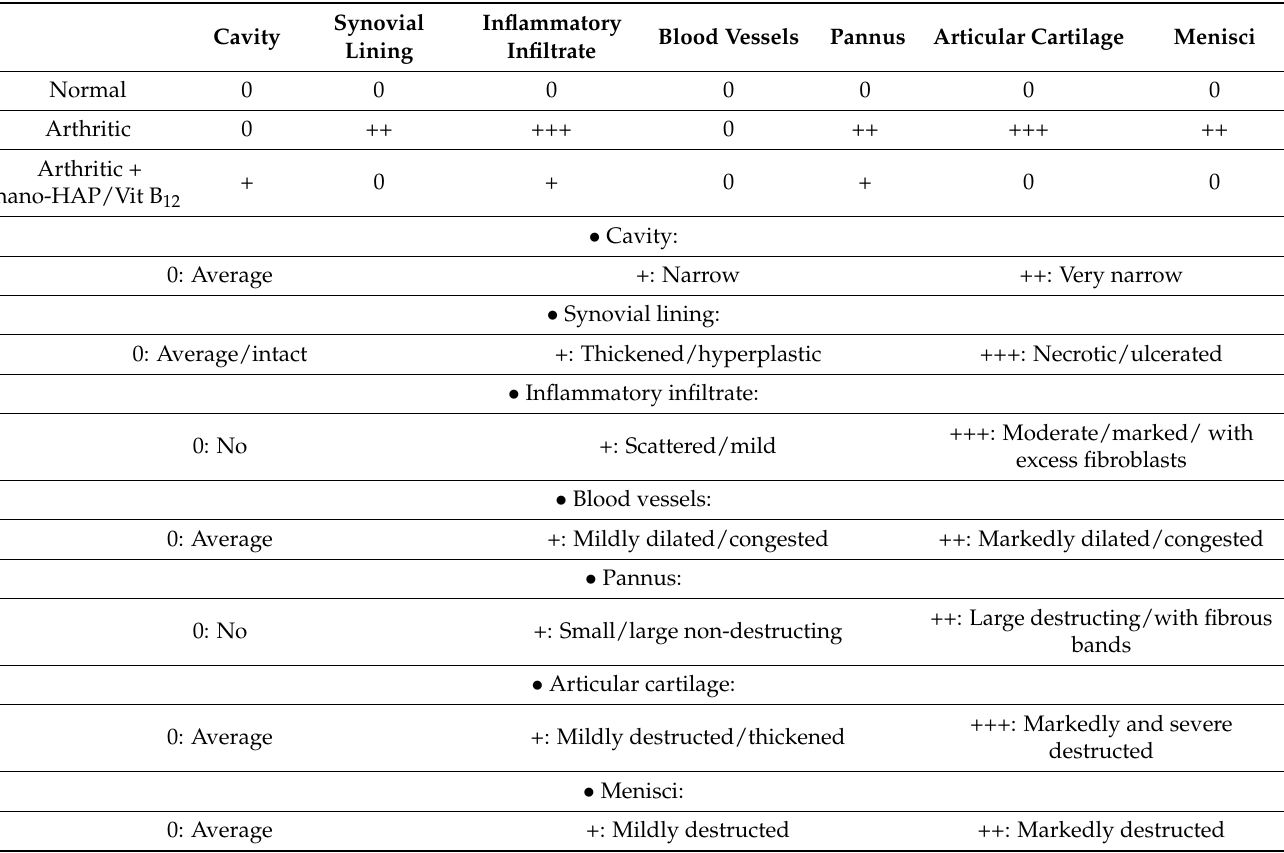
Figure 9. ( A ) In normal rats: high-power view showing average joint cavity (black arrow), average synovial lining (blue arrow), average sub-synovial tissue (yellow arrow), average articular cartilage with intact superficial layer (red arrow), and average menisci (green arrow) (H&E X 200). ( B ) In arthritic rats: high-power view showing destructed Pannus on and on menisci (red arrow), and marked sub-synovial inflammatory infiltrate (yellow arrow) (H&E X 200). ( C ) In nano-HAP/Vit B 12 -treated rats: joint showing narrow joint cavity (black arrow), mildly destructed articular cartilage (red arrow), and intact synovial lining (blue arrow) with marked sub-synovial inflammatory infiltrate (yellow arrow) (H&E X 100). Table 1. Ankle histological lesion scores in normal, arthritic, and arthritic treated with nano-HAP/Vit B 12 rats’